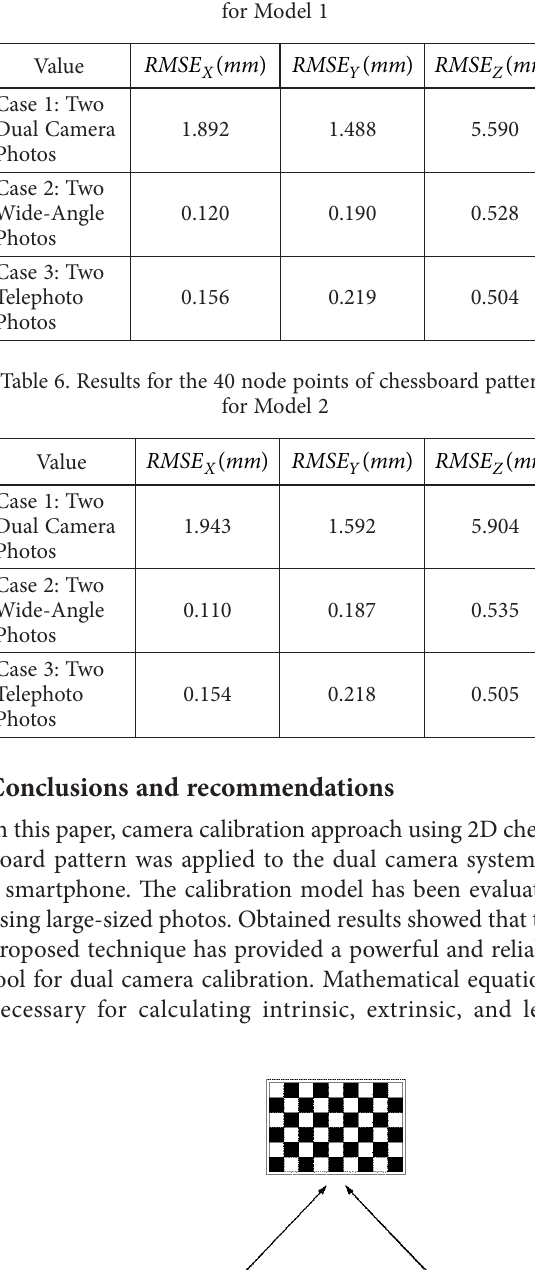
Table 5. Results for the 40 node points of chessboard pattern